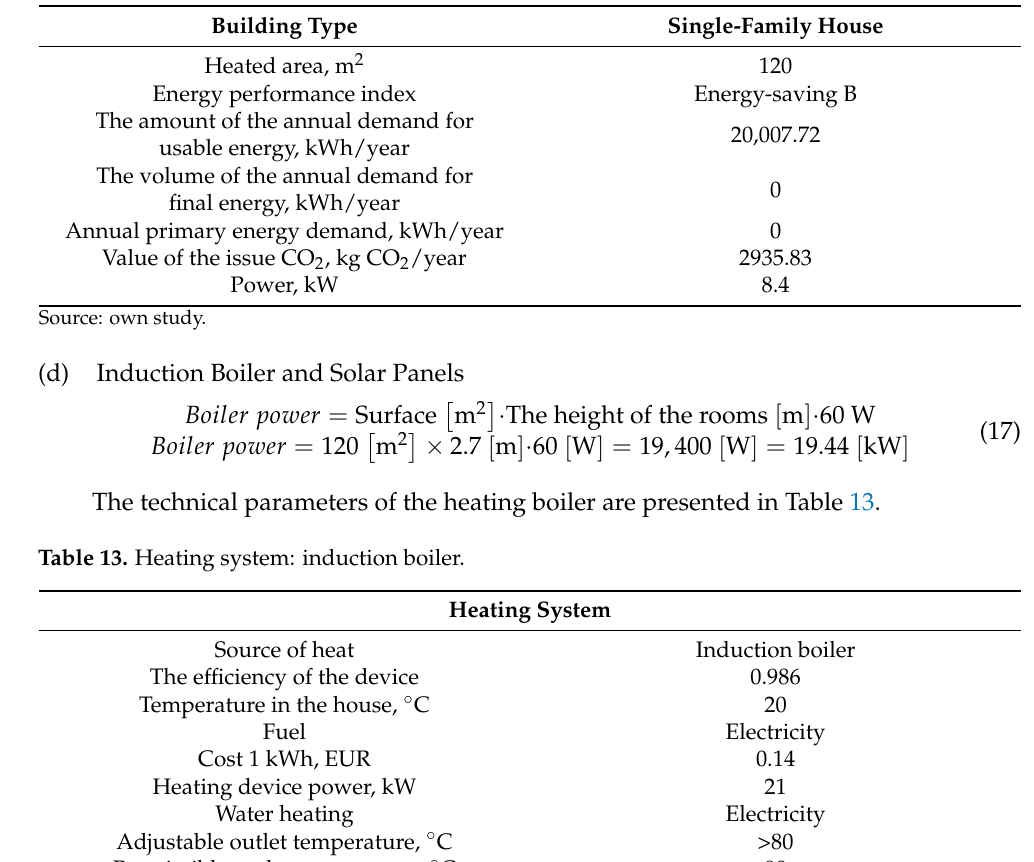
Table 12. Building energy parameters after using an air heat pump and photovoltaic panels.